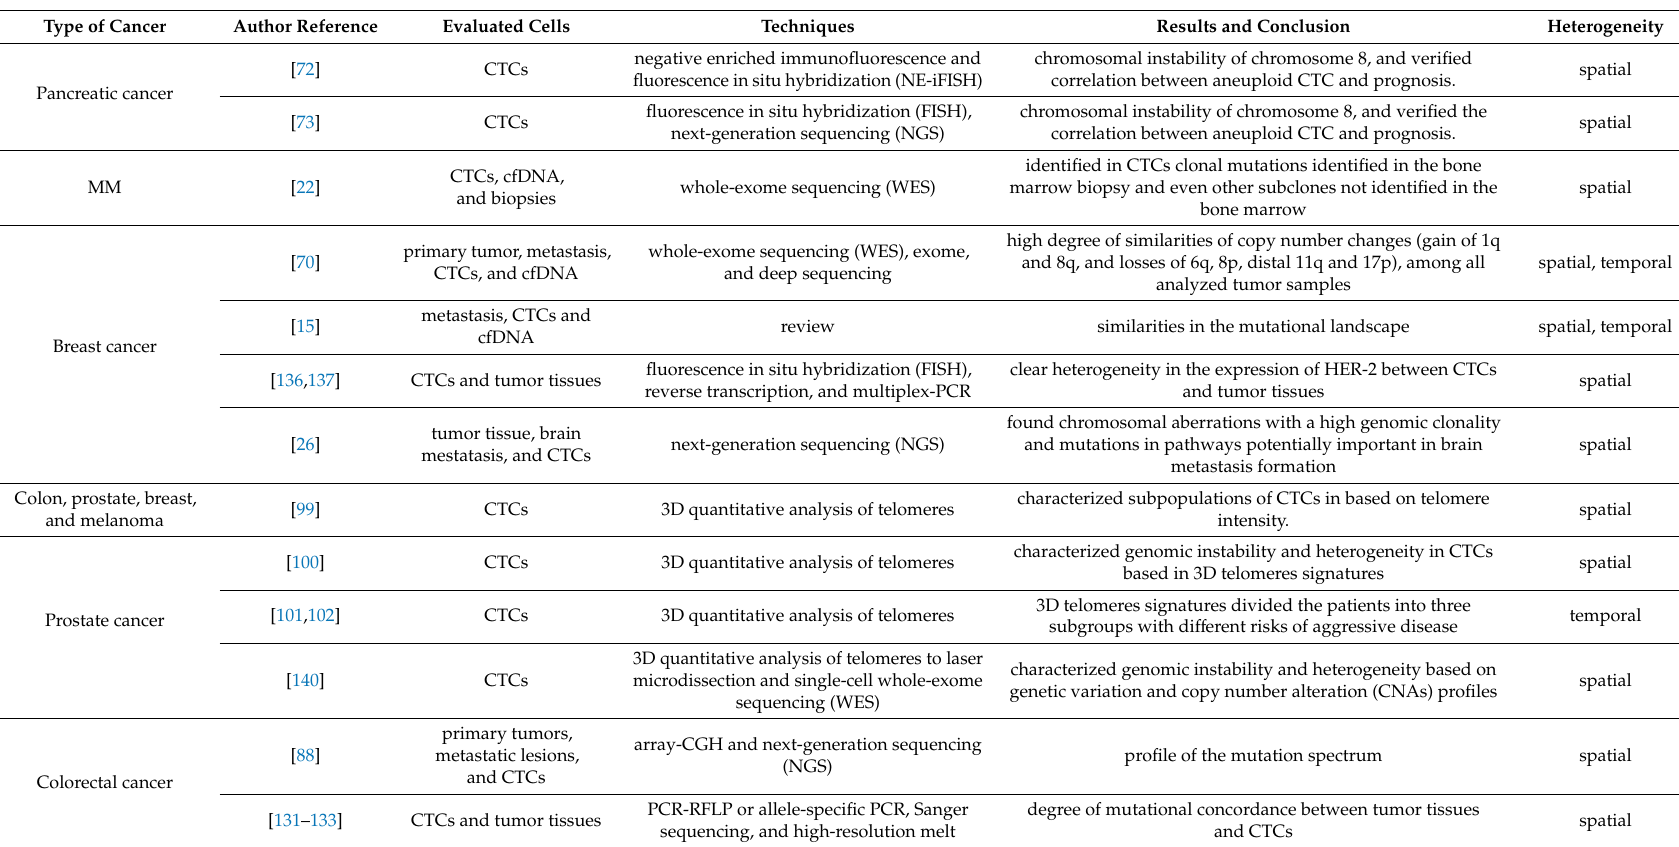
Table 1. Studies of chromosome instability (CIN) analyses that contribute to the characterization of spatial or temporal tumor heterogeneity. Spatial heterogeneity reflects di ff erences within a single tumor or between the primary tumor and metastasis and temporal heterogeneity reflects the presence of low-frequency tumor subclones and dynamic changes in cellular biomarkers of tumor cells during disease progression. CTCs: circulating tumor